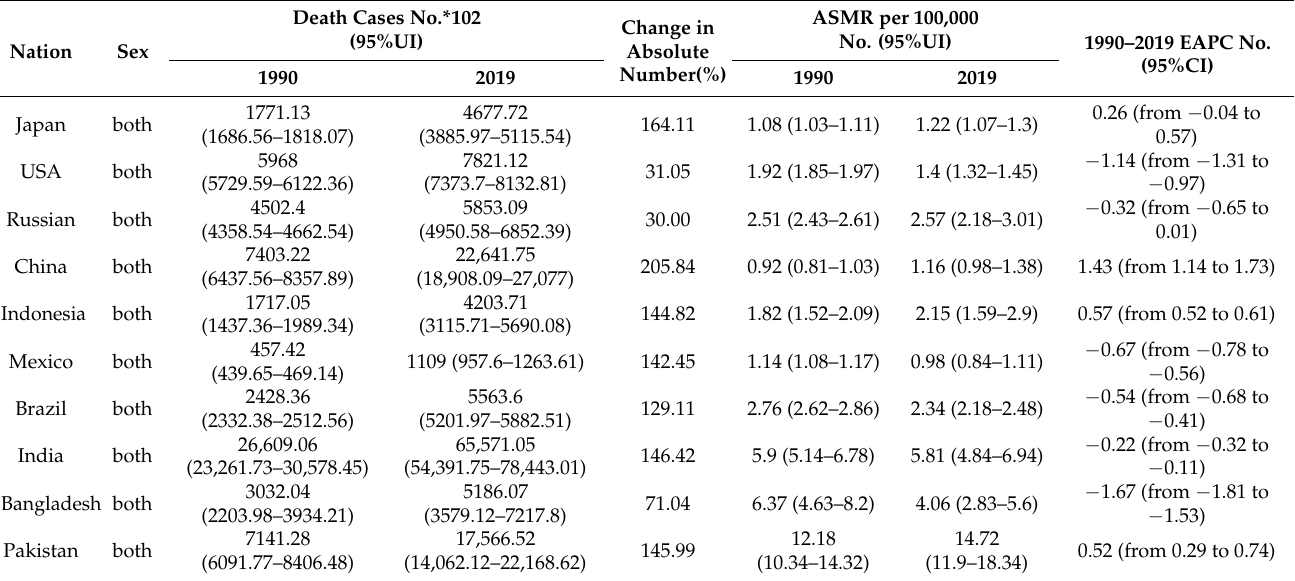
Table 2. The death cases and age-standardized death rate of oral cancer in 1990 and 2019, and its temporal trends from 1990 to 2019. (Countries are ranked from highest to lowest in